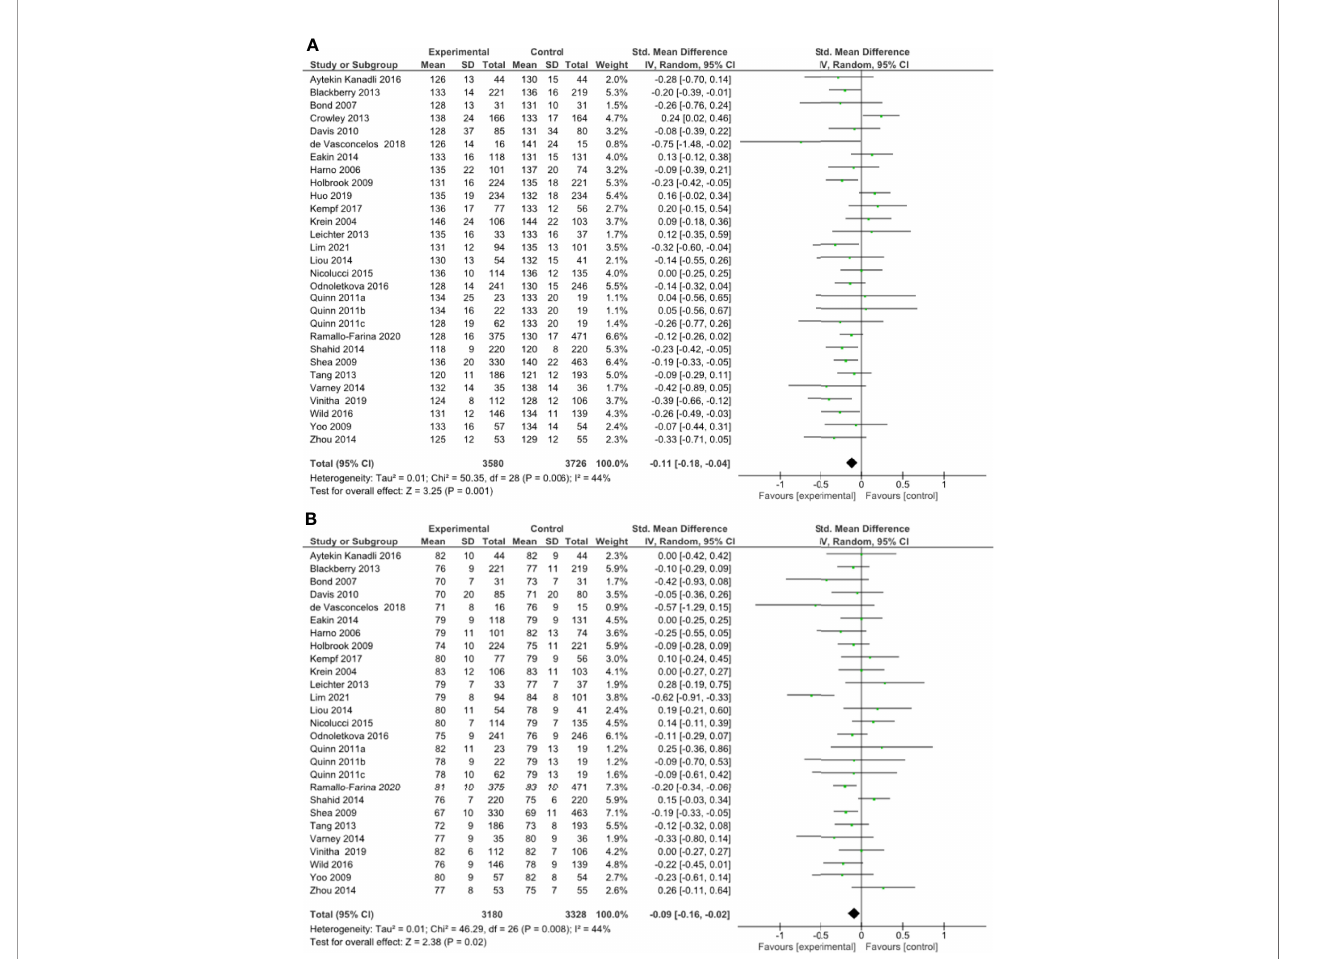
FIGURE 3 | (A) Forest plot showing the effect of remote management on systolic blood pressure, (B) Forest plot showing the effect of remote risk factor management on diastolic blood